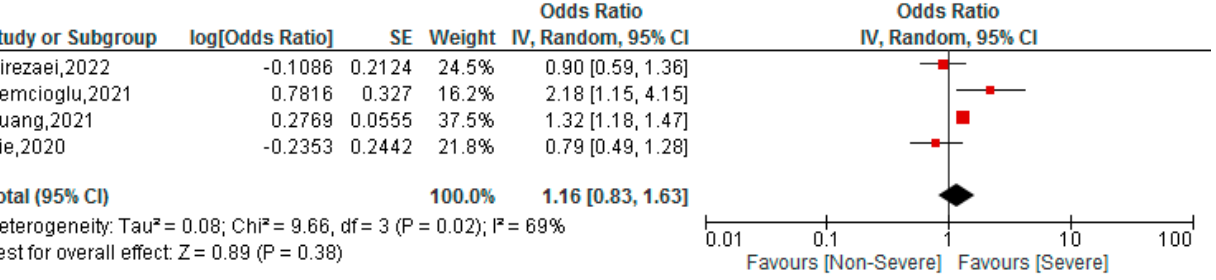
Figure 4. Association between BAR and severity of COVID-19 patients [33,44,45,49].